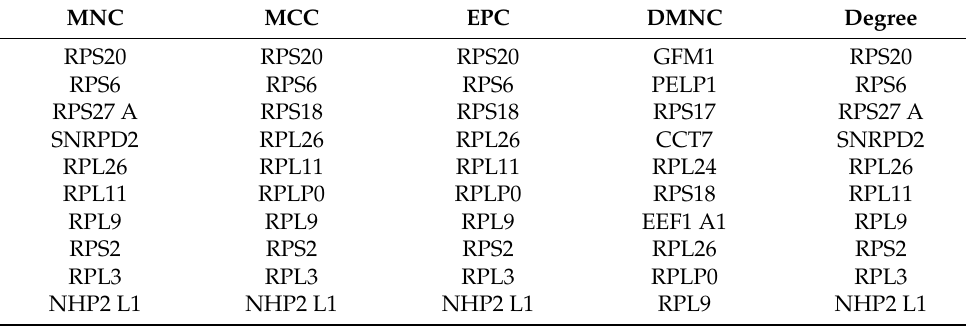
Figure 5. Gene set enrichment analysis. ( A ) Enrichment plot of ‘TNFA_SIGNALING_VIA_NFKB’ with enrichment score 0.57, FDR q -value 0.0. ( B ) Enrichment plot of ‘IL6_JAK_STAT3_SIGNALING’ with enrichment score 0.67, FDR q -value 0.0. ( C ) Enrichment plot of ‘INFLAMMATORY_RESPONSE’ with enrichment score 0.51, FDR q -value 0.004. ( D ) Enrichment plot of ‘HYPOXIA’ with enrichment score 0.46, FDR q -value 0.0025. ( E ) Enrichment plot of ‘HEDGEHOG_SIGNALING’ with enrichment score 0.54, FDR q -value 0.05. ( F ) Enrichment plot of ‘APICAL_JUNCTION’ with enrichment score 0.40, FDR q -value 0.047. Table 2. Top ten hub genes obtained by five algorithms of Cytohubba. MNC MCC